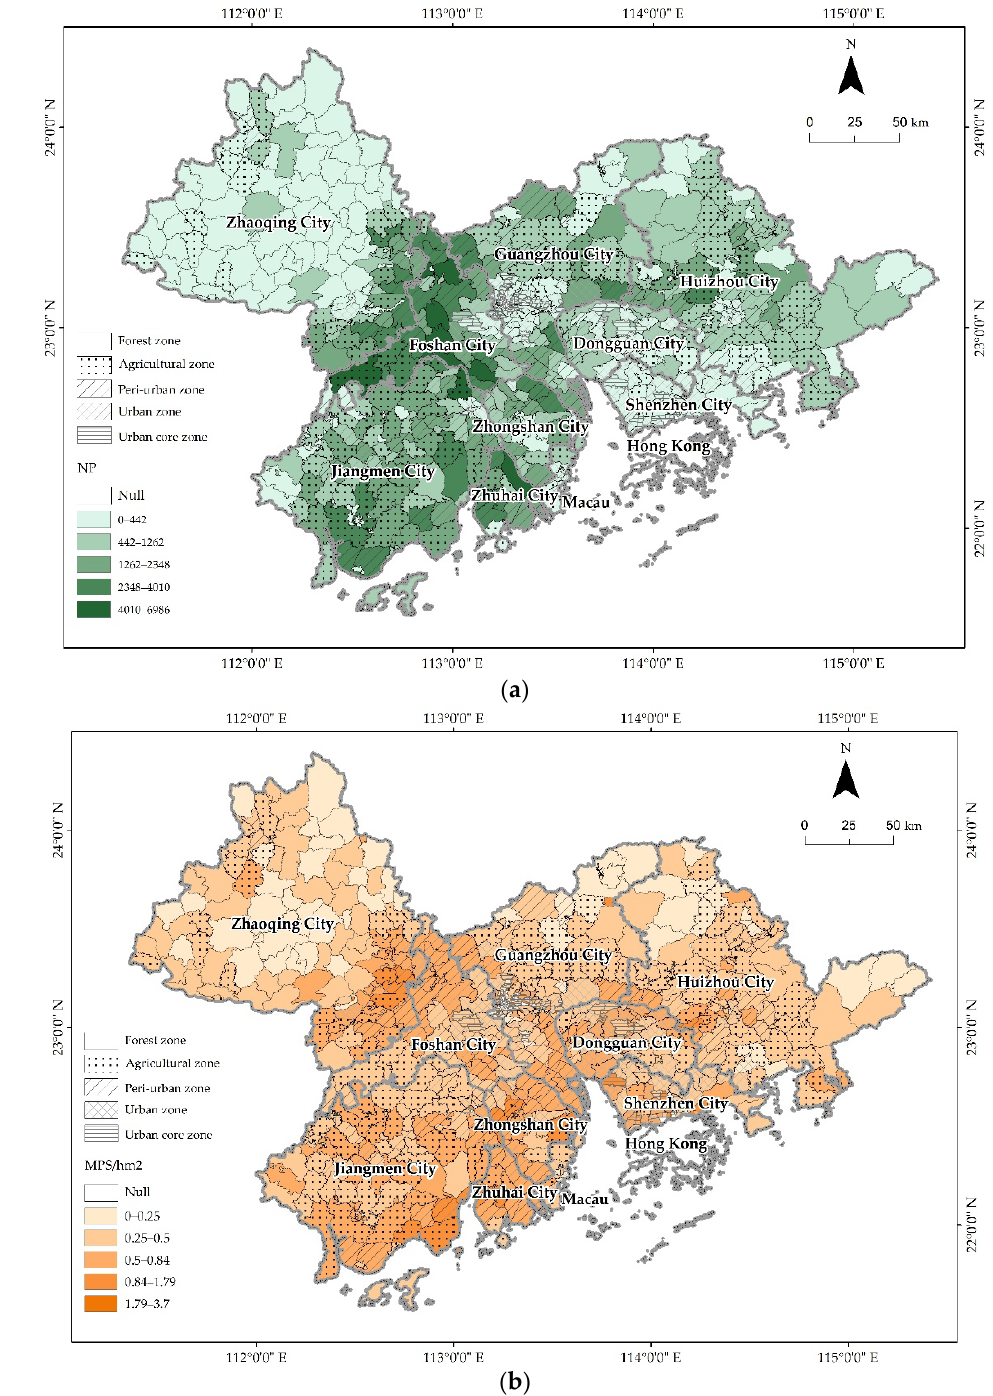
Figure 8. Spatial variation in ( a ) number of pond patches (NP) and ( b ) mean patch area (MPS) across an urban-rural gradient (urban core to forest) in the PRD.